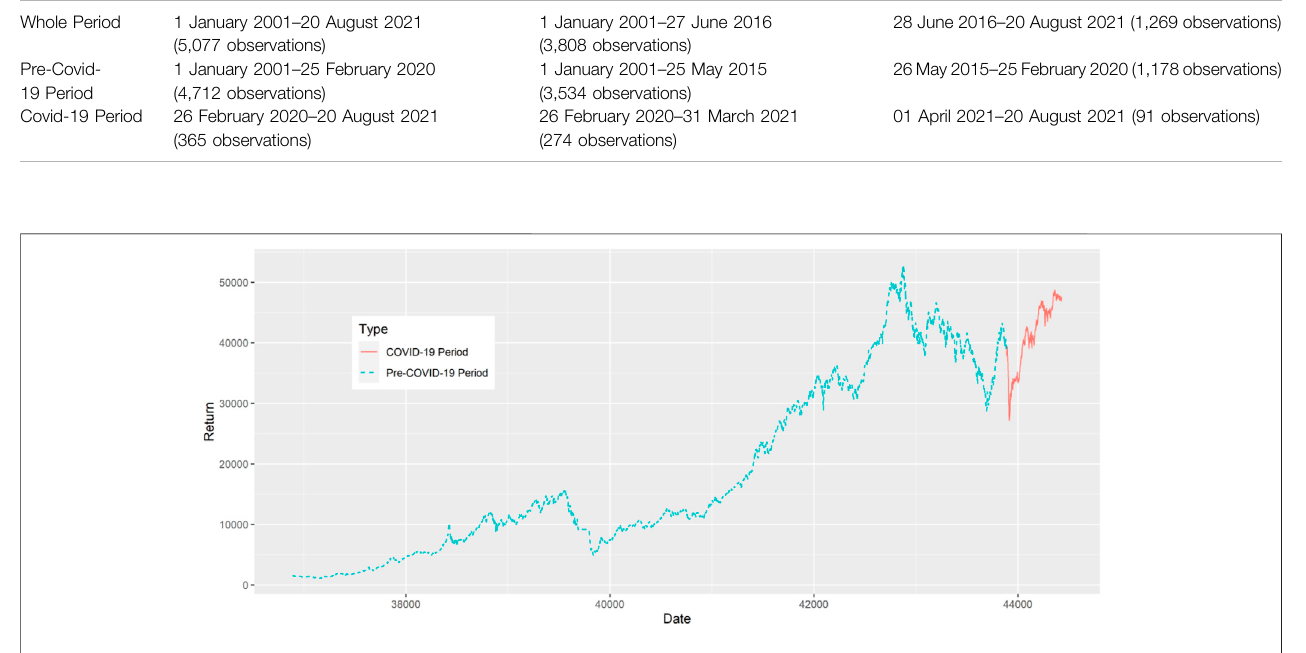
FIGURE 1 | Time-series plot of stock index prices.